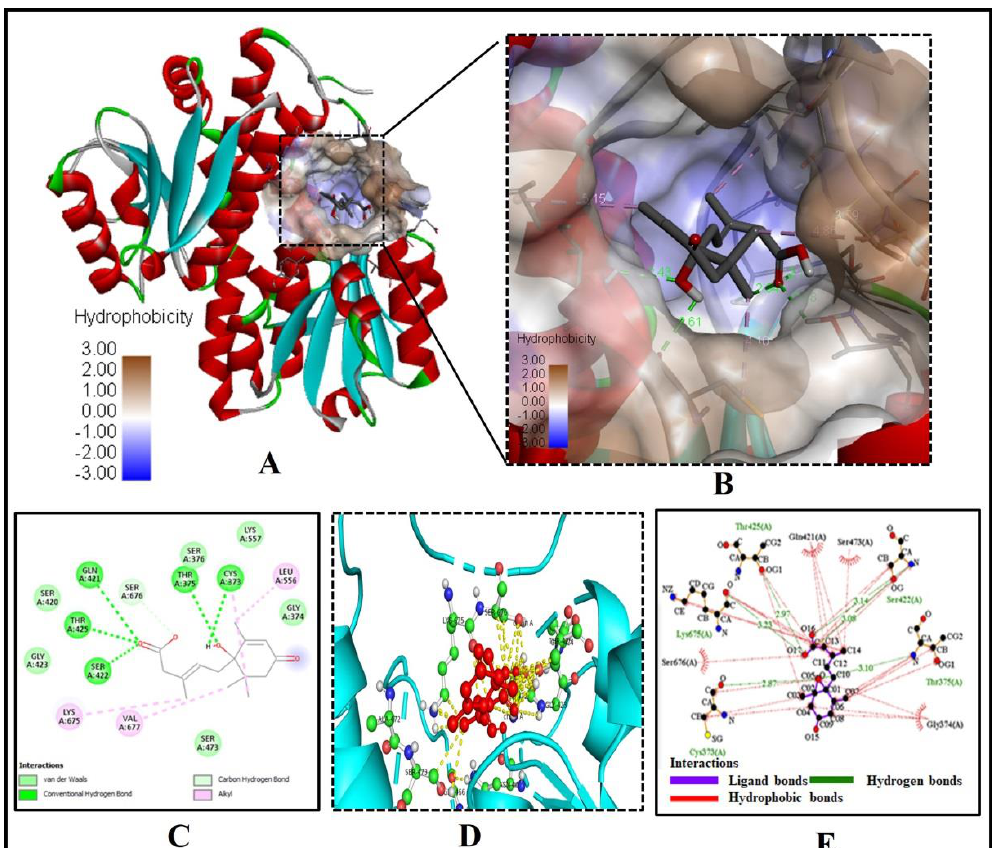
Figure 3. ABAs significant molecular binding with human glutamine-fructose-6-phosphate amidotransferase [GFAT (PDB ID- 2ZJ4)]. ( A ) ABA binding with the binding pocket. ( B ) Enlarged view showing the hydrophobicity of amino acid residues of the binding cavity ( C ) The 2D plot shows the molecular level interactions of binding pocket residues with the inhibitor ABA. ( D ) The 3D image shows strong interactions (yellow dashed lines) of ABA (red ball and sticks) with the functionally important residues (green ball and sticks) of human glutamine-fructose-6-phosphate amidotransferase. ( E ) The 2D LigPlot+ image shows the atomic level interactions of binding pocket residues with the